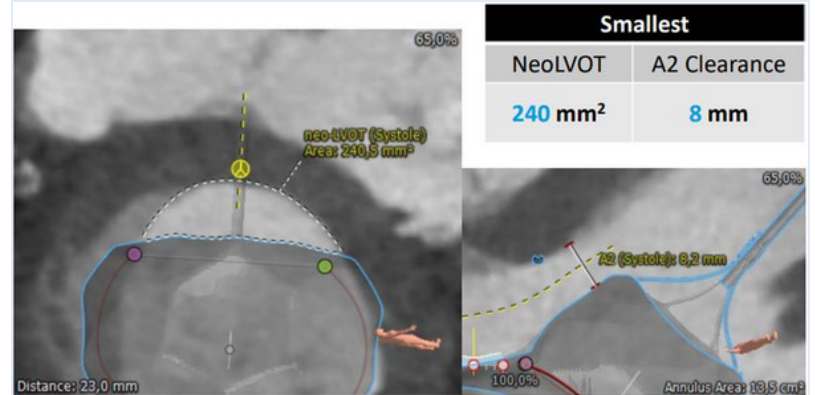
Figure 2 postoperative TTE showing immaculate prosthesis function